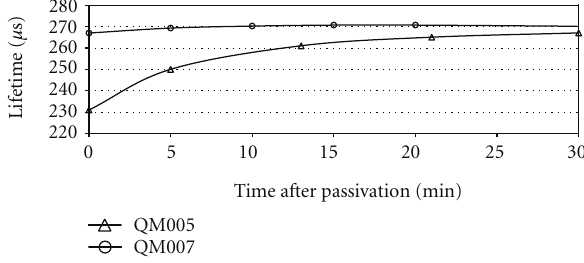
Figure 1: Time stability of iodine passivation.